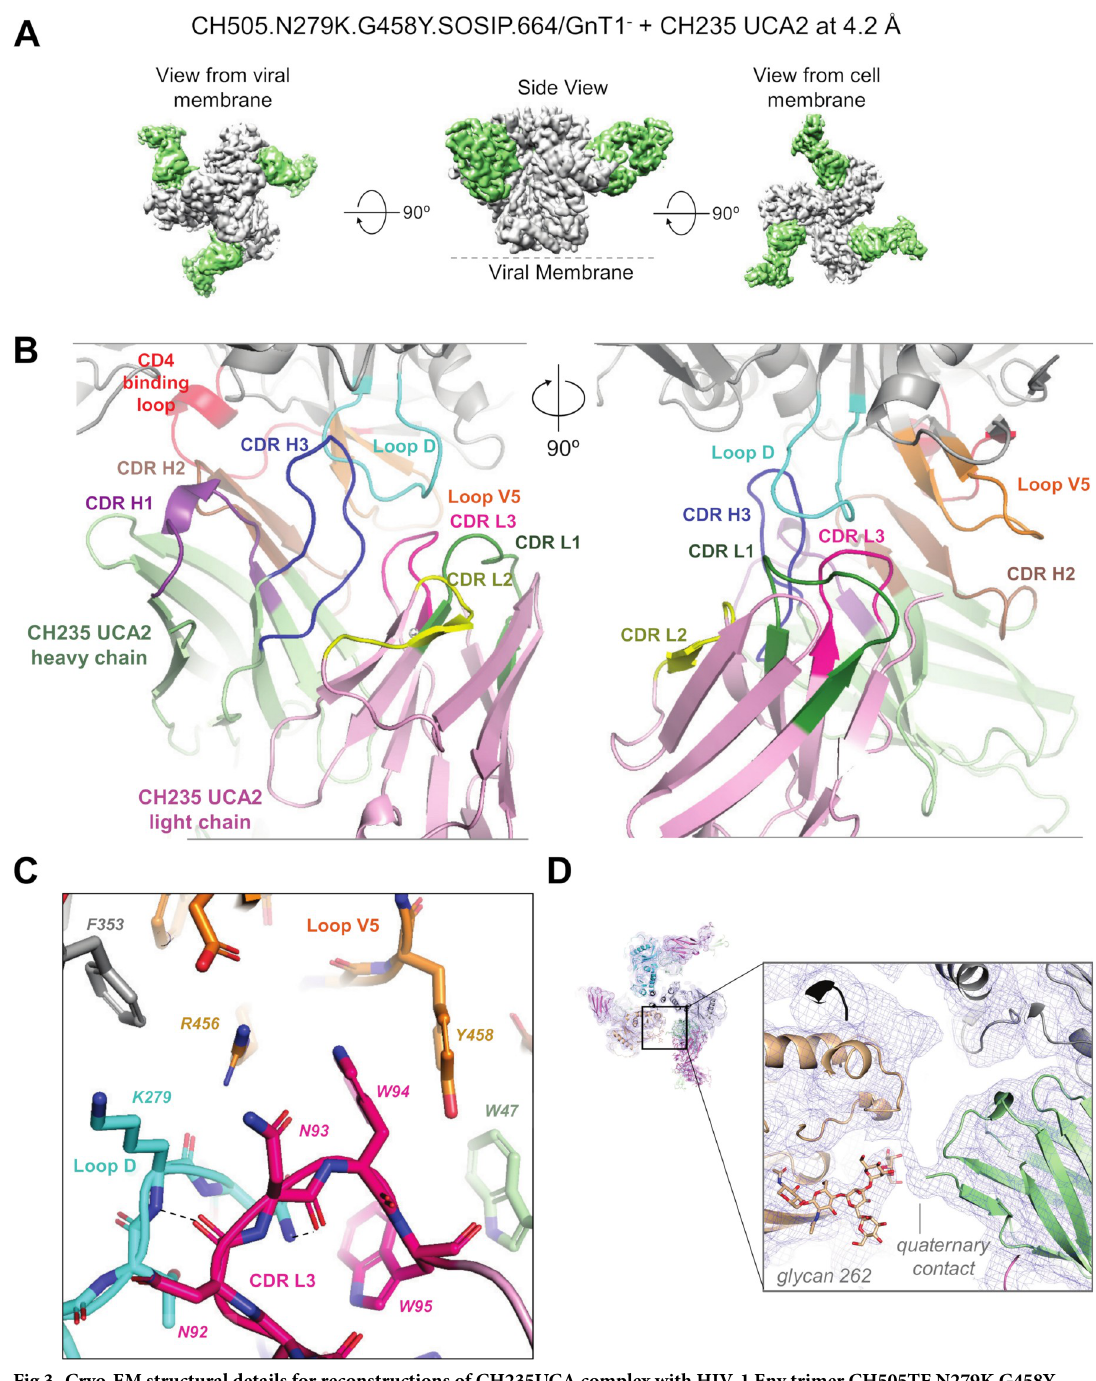
Fig 3. Cryo-EM structural details for reconstructions of CH235UCA complex with HIV-1 Env trimer CH505TF.N279K.G458Y. SOSIP.664. (A) Cryo-EM reconstruction of CH235 UCA2 bound to stabilized CH505TF.N279K.G458Y.SOSIP.664/GnT1 - trimer, shown segmented by component with CH235 UCA2 colored green and HIV-1 Env colored gray. (B) Zoomed-in view of the CH235 UCA2 binding interface with Env. The Env CD4 binding loop is shown in red, loop D in cyan, and loop V5 in orange. The CH235 UCA2 heavy chain is colored green, with the CHR H1, CDR H2 and CDR H3 loops colored purple, brown and blue, respectively. The CH235 UCA2 light chain is colored pink, with the CDR L1, CDR L2 and CDR L3 loops colored green, yellow, and magenta, respectively. The view on the right is rotated 90˚ clockwise with respect to the view shown on the left. (C) Zoomed-in view showing the interactions of the CH235 UCA2 CDR L3 (magenta) with the HIV-1 Env loop D (cyan) and loop V5 (orange). CDR H2 is shown in brown. The interactive residues are shown in stick representation and the black dotted lines indicate hydrogen bond interactions. (D) Left, cryo-EM